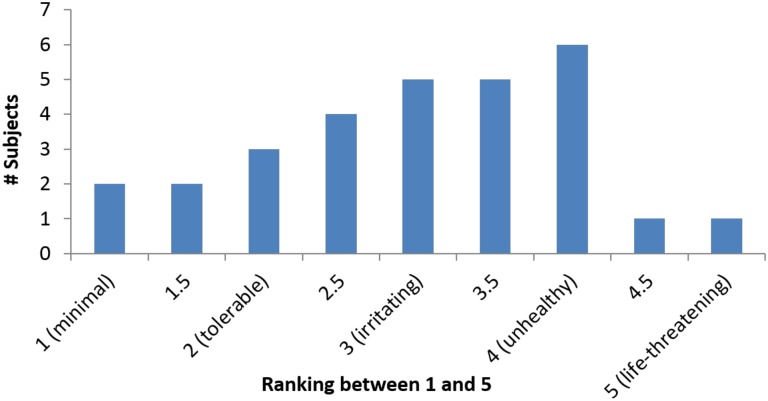
Subjects’ perceived exposure level of DE.